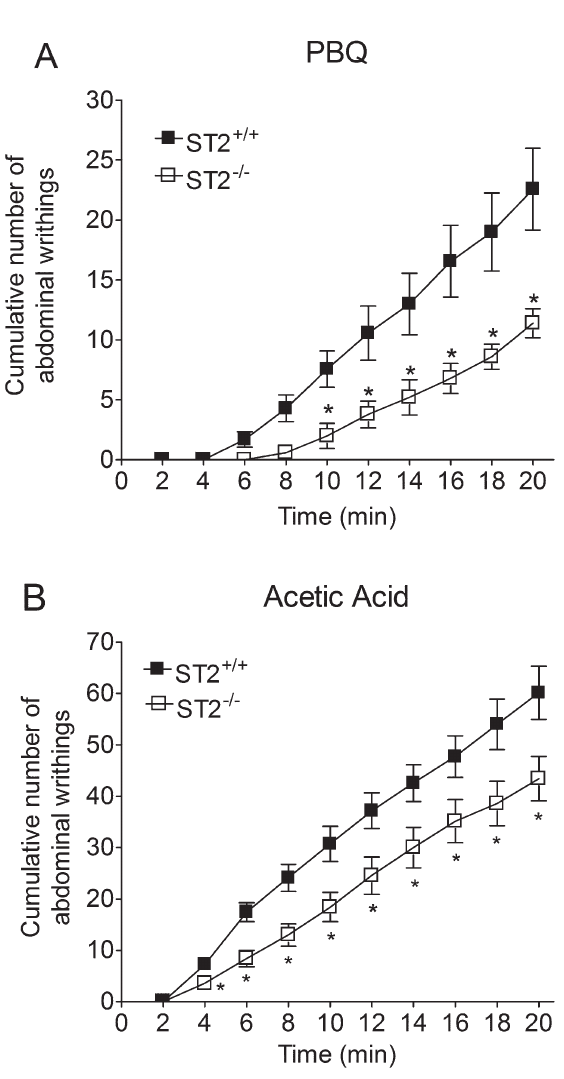
Figure 1. Role of IL-33/ST2 receptor in phenyl- p -benzoquinone (PBQ)- and acetic acid-induced writhing responses. ST2 +/++ and ST2 -/- mice received an intraperitoneal injection (10 mL/kg) of A , PBQ (630 m g diluted in 10 mL 2% DMSO in saline) or B , 0.6% acetic acid diluted in saline. The cumulative number of writhing responses was evaluated between 0 and 20 min and reported at 2-min intervals. n=7 per group per experiment, representative of two separate experiments. *P , 0.05, compared to the ST2 +/++ group (Student t -test).